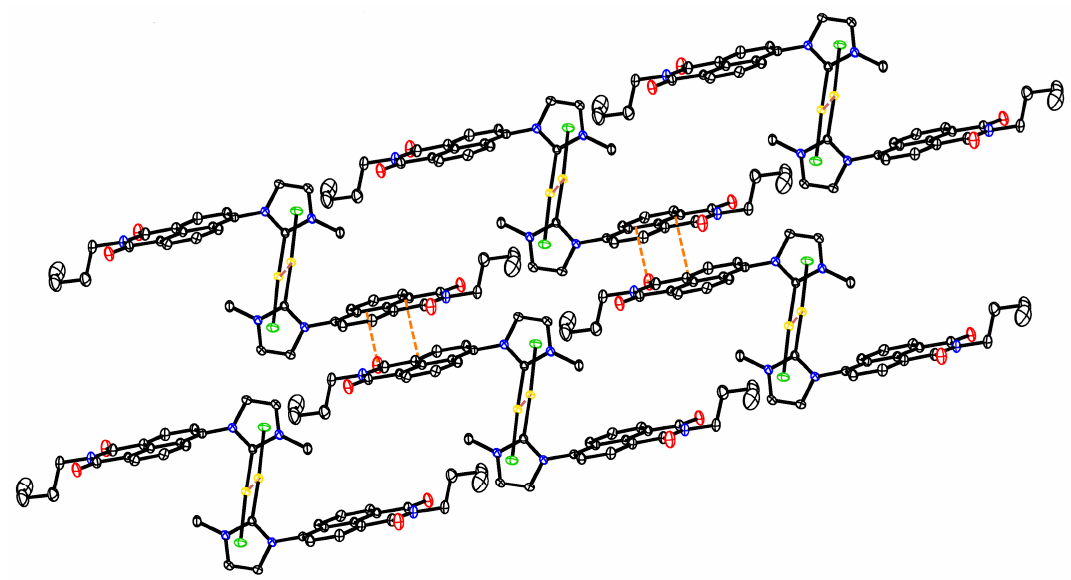
Figure 3. Crystal packing of 1c showing aurophilic Au ··· Au contact at 3.407(1) Å between two individual molecules in head-to-tail fashion and π – π interactions at 3.40 Å between two naphthalimide units to generate a 2D supramolecular structure.